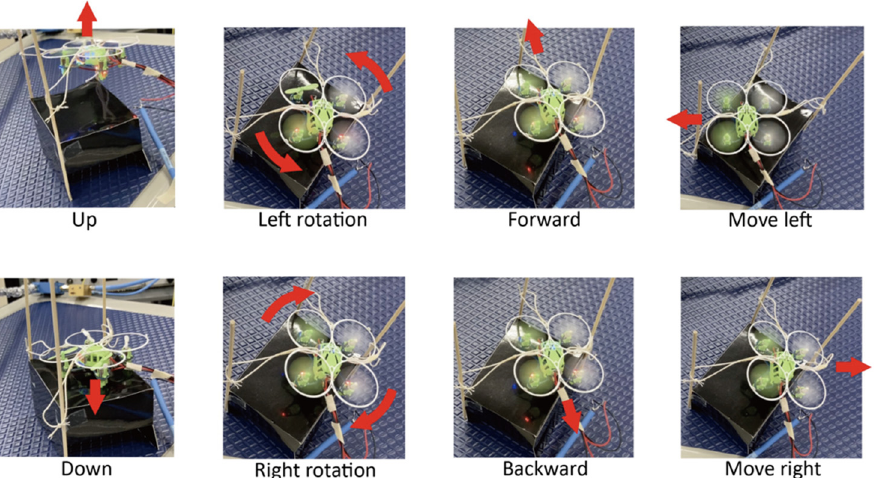
Figure 6. Photographs illustrating control of optically controlled drone. Red arrows indicate direction in which the drone is moving.